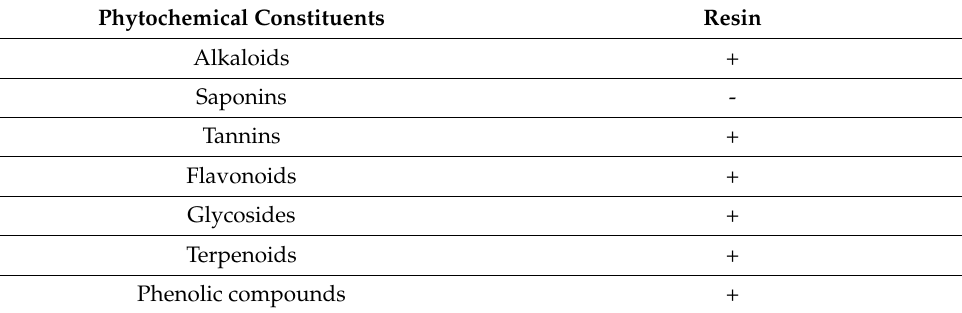
Table 1. Phytochemical screening of